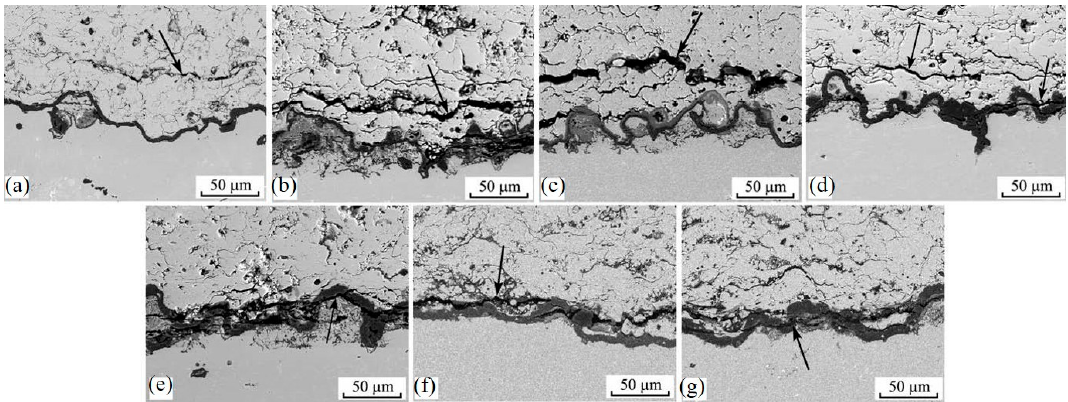
Figure 4. The cracking modes of TBCs with the TGOs (thermally-grown oxides) of different thicknesses: ( a ) 1.3 μ m, ( b ) 2.7 μ m, ( c ) 3.9 μ m, ( d ) 5.0 μ m, ( e ) 6.5 μ m, ( f ) 7.0 μ m, ( g ) 7.7 μ m. Reprinted with permission from [43]; Copyright 2012 Elsevier.